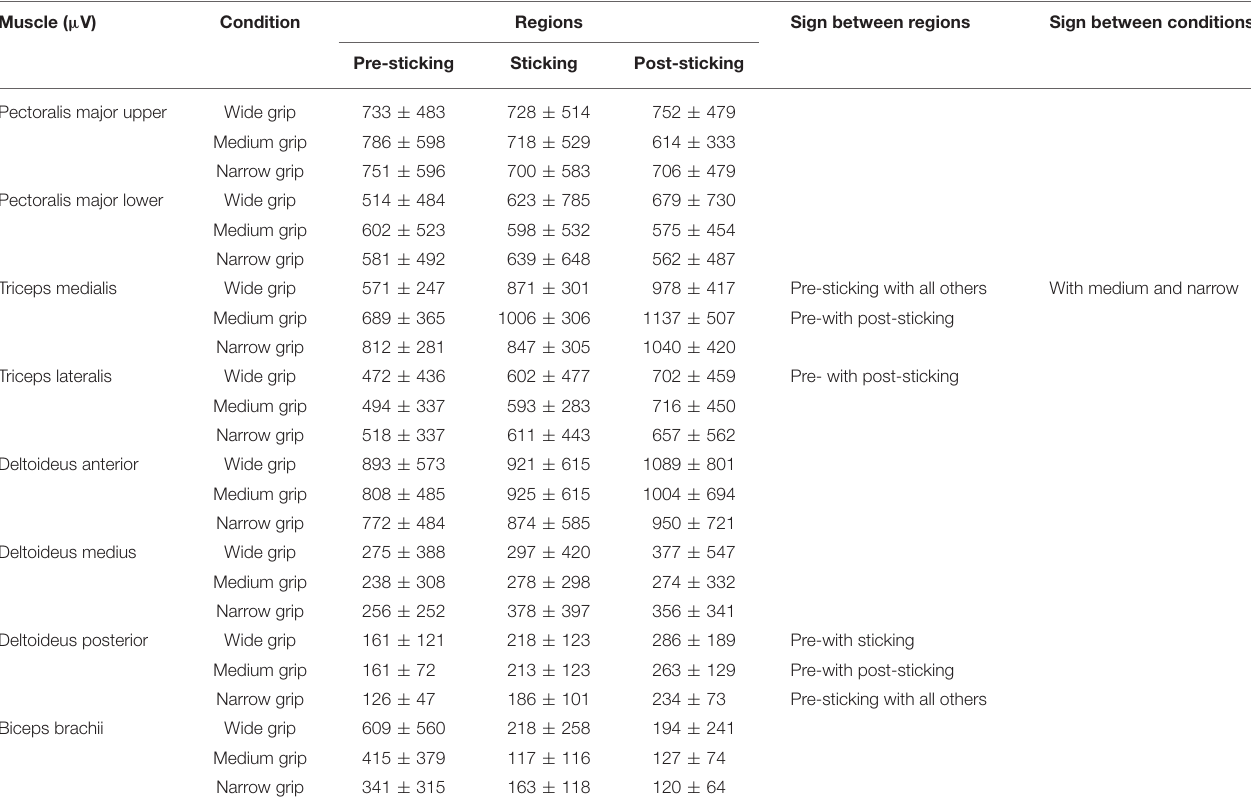
TABLE 3 | Mean RMS (SD) electromyography activity of eight upper limb muscles in the pre-sticking, sticking and post-sticking region of the wide, medium, and narrow grip bench press. Muscle ( µ V) Condition Regions Sign between regions Sign between conditions